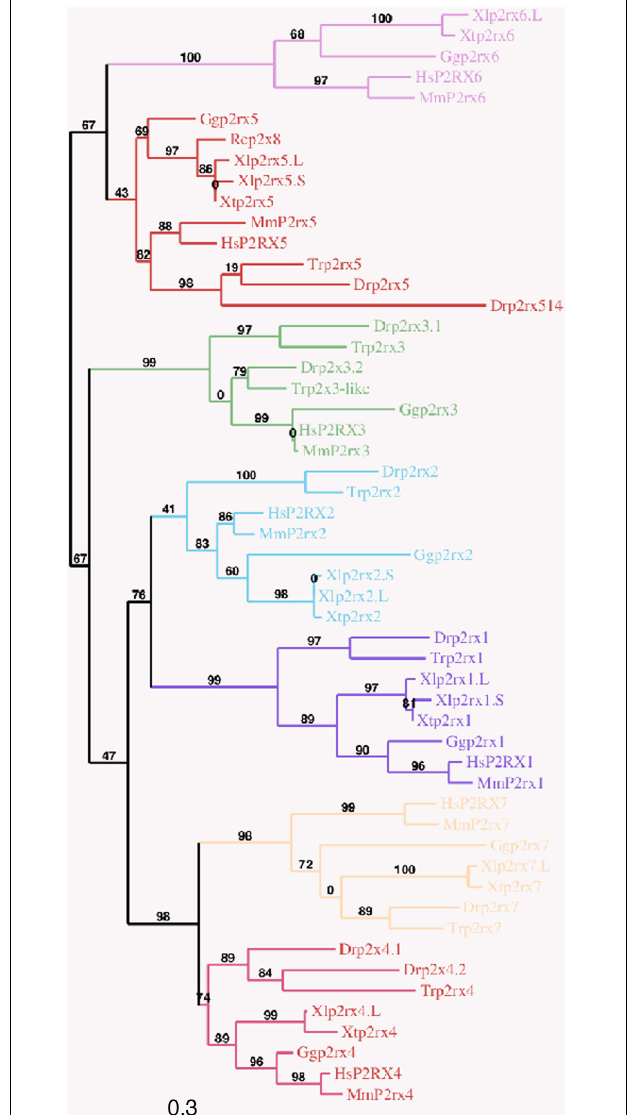
FIGURE 1 | Phylogenetic conservation of the vertebrate p2x receptor subunits. A phylogenetic tree of the p2rx subunits family based on African clawed frogs ( Xenopus laevis , Xl and Xenopus tropicalis , Xt), human ( Homo sapiens , Hs), mouse ( Mus musculus , Mm), chicken ( Gallus gallus , Gg), zebrafish ( Danio rerio , Dr), Japanese puffer ( Takifugu rubripes, Tr) and American bullfrog ( Rana catesbeiana , Rc) was constructed on the plastform phylogeny.fr, using the Maximum Likelihood method. Bootstrap percentages (ranging from 0 to 100) are indicated at each node of the tree while branch lengths are representative of sequence substitution rates. P2rx1, 2, 3, 4, 5, 6, 7 subunit subfamilies are respectively colored in purple, blue, green, dark pink, red, light pink, and orange. The Genbank accession numbers of the different receptors are given in the Supplementary Tables S1A,B except for Rcp2rx8 (Accession Number: